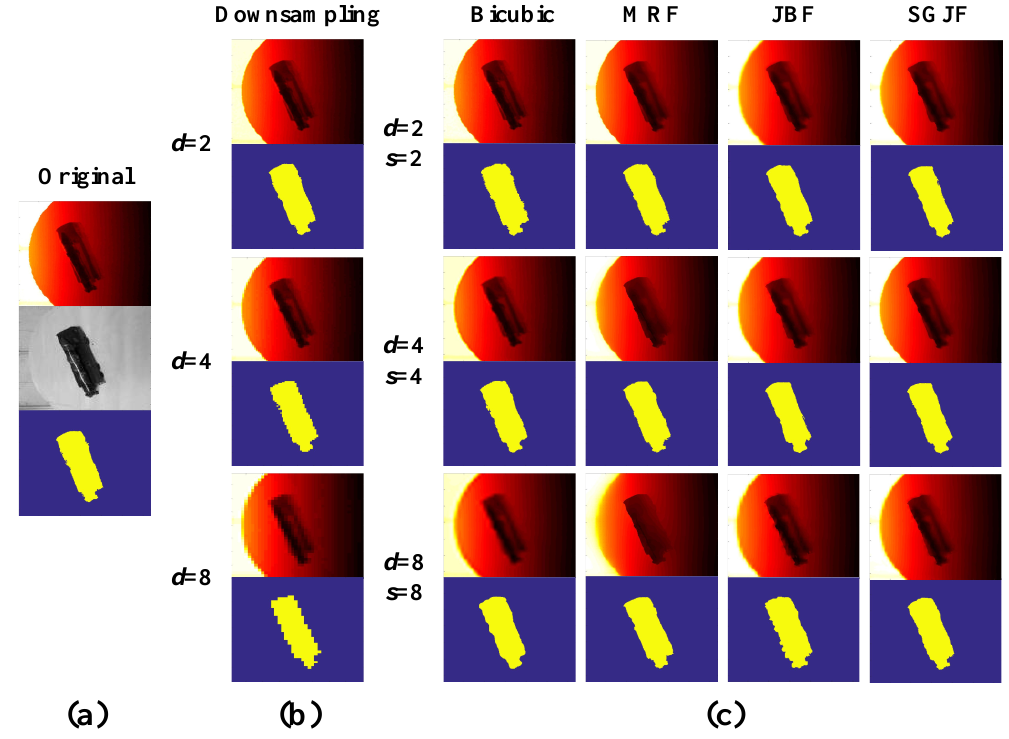
Figure 5. Explanation of the experiment phenomenon. ( a ) Original images. ( b ) Down-sampled images. ( c ) Super-resolved images. Sensors 2020 , 20 , x FOR PEER REVIEW